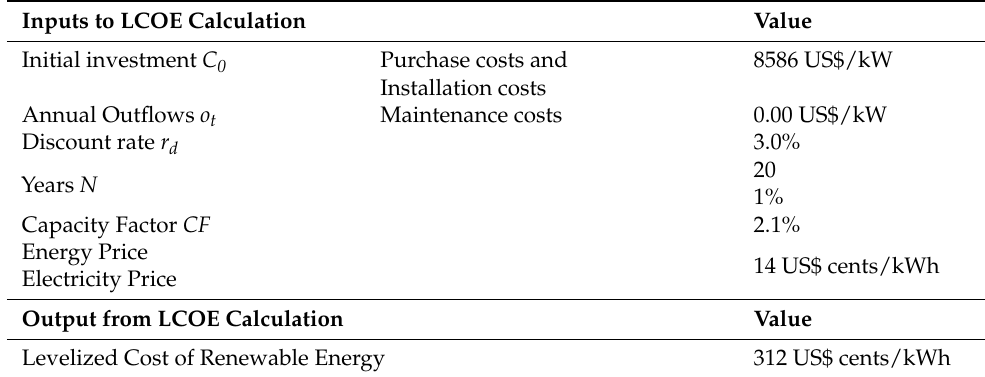
Table 3. Analysis of the Levelized Costs of Electricity result (LCOE).